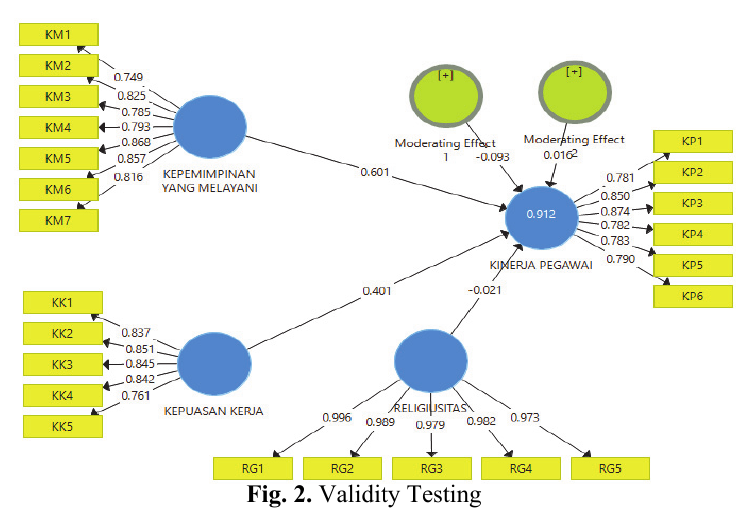
Fig. 2. Validity Testing